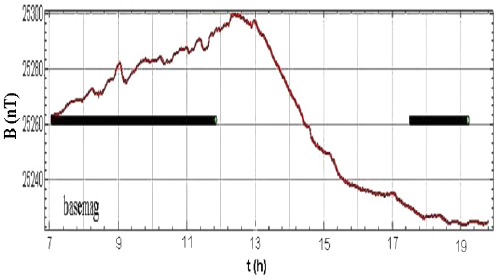
Figure 16. Example of the diurnal magnetic field curve acquired at a BaseMag station (source: S. Guimarães, author private collection, May 2007).